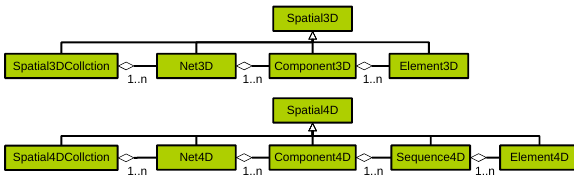
Figure 1. Hasse diagram of a triangle with its boundary relation. Hasse diagram such that the reflexive and transitive closure of the edge relationship yields the topology in the sense of (Al- exandrov, 1937). Fig. 1 illustrates this for the example of a triangle: The top node represents the area which is bounded by its three side edges, represented by the middle row of nodes, and each of these are bounded by two corners represented by the lower row of nodes. The edges are oriented downwards and represent the boundary relationship between objects.